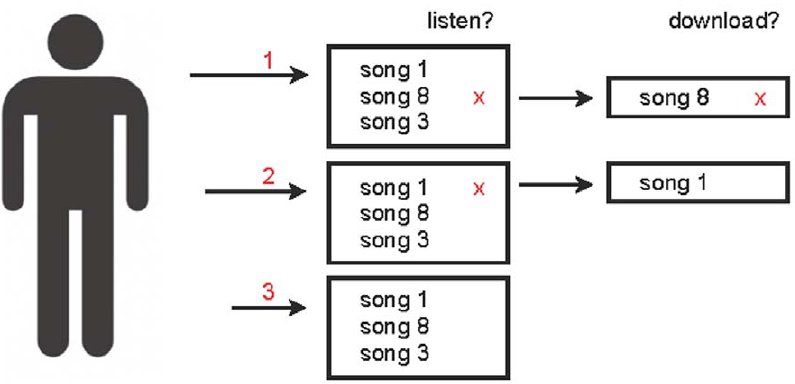
Figure 3. Song selection as a two-step process. A listen first selects which song(s) he will listen to, and after listening, decides whether or not to download the song. The first decision is made based on the appeal of a song; the second based on its quality. If a listener listens to more than one song, this process is repeated.